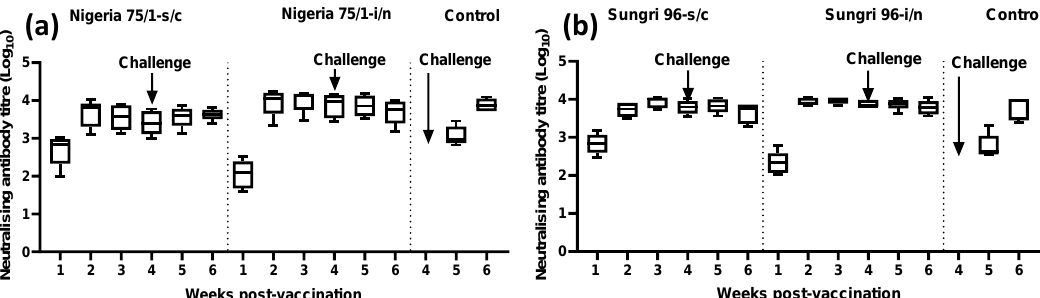
Figure 4. Neutralizing antibody response in goats following vaccination and challenge. The data are presented as box-and-whisker plots, in which the bars span the minimum and maximum values of five animals, and the box shows the range from the first to the third quartile. The central horizontal line in each box shows the median value. Day of challenge is shown by an arrow in each graph. ( a ) Neutralizing antibody titers in Nigeria 75 / 1 vaccine study; ( b ): neutralizing antibody titers in Sungri 96 vaccine study.